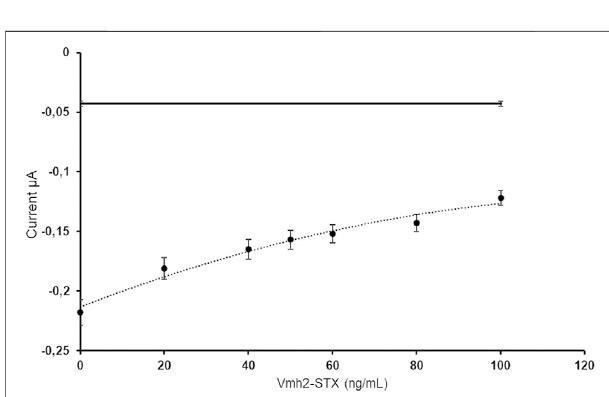
FIGURE 3 | Electrochemical measurements of the free Vmh2-ScFv STX / anti-STX competitive assay with the dashed line as an eye-guide. The horizontal line indicates the electrochemical background